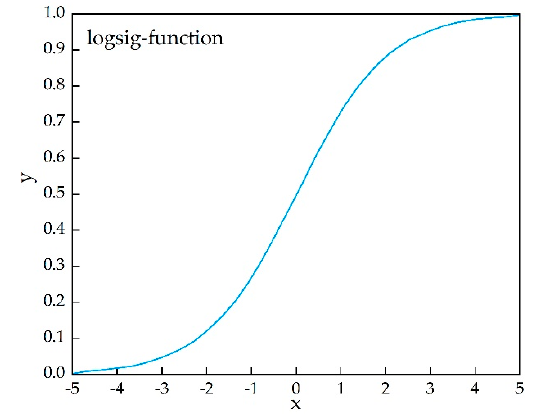
Figure 6. Logsig function curve.